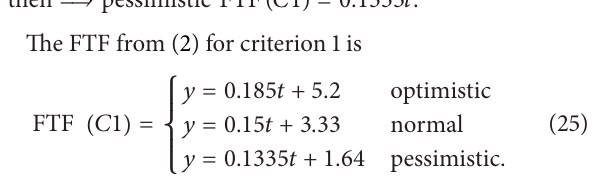
Table 5: Green supply chain criteria considering time.